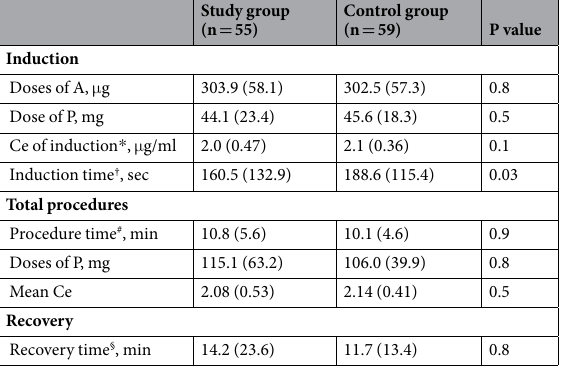
Study group (n = 55)